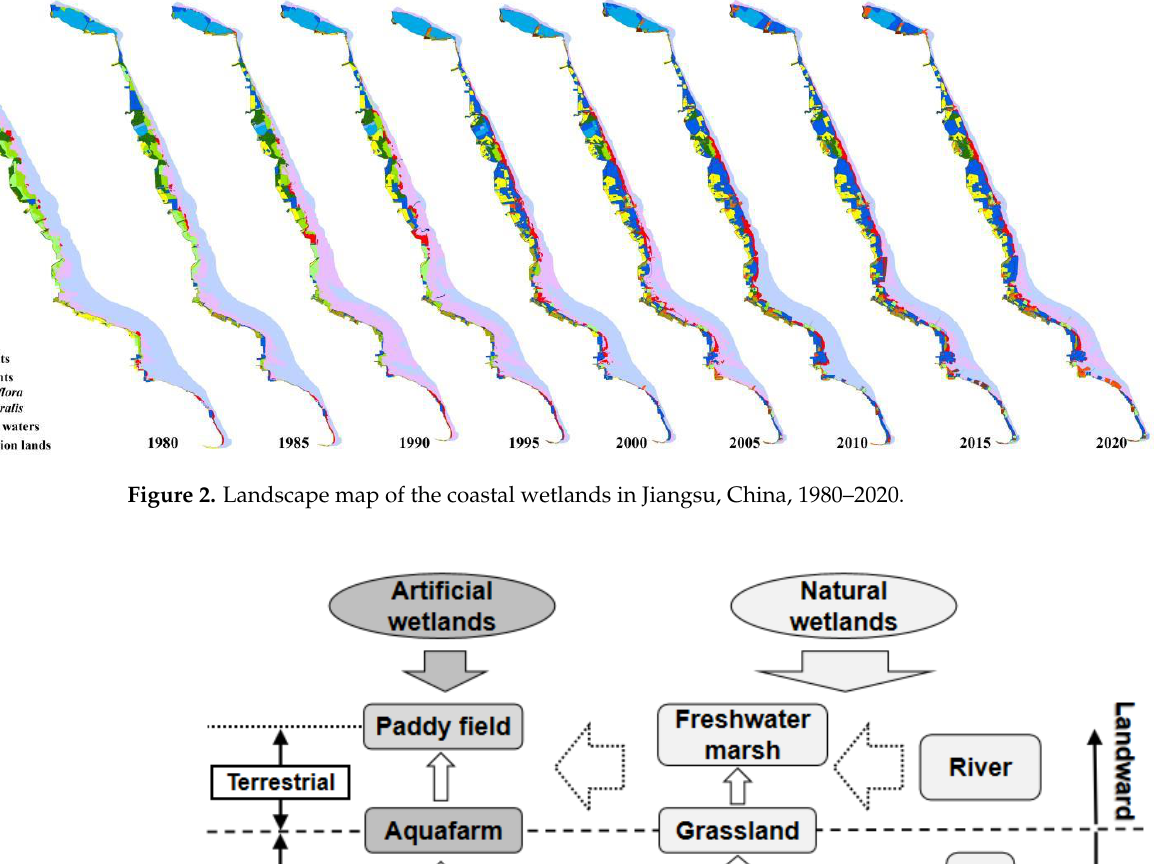
Figure 2. Landscape map of the coastal wetlands in Jiangsu, China, 1980–2020.